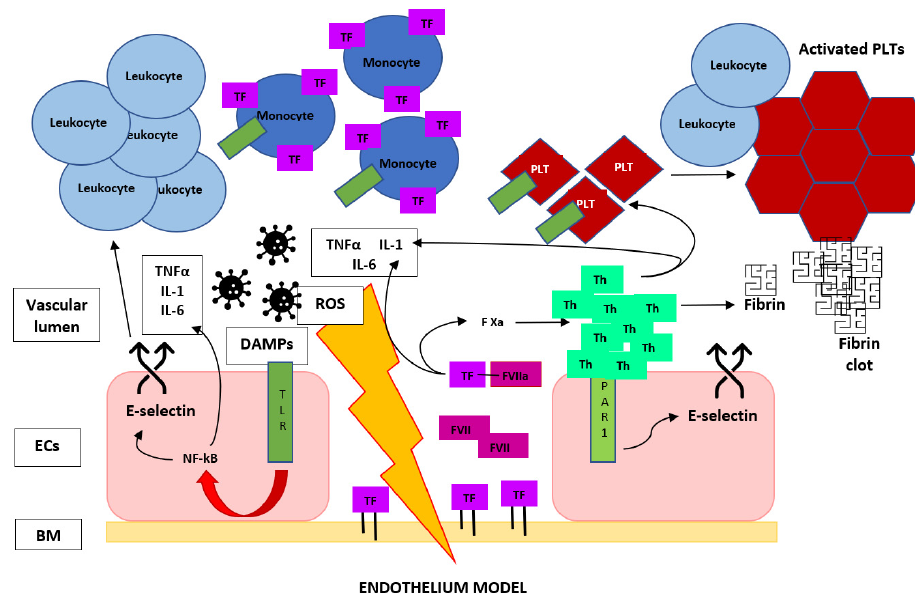
Figure 3. Brief graphic description of the escalating circle of events that start from vascular wall damage and lead to the crosstalk between the coagulation cascade and immune system in a potent positive feedback loop toward venous thrombus formation during sepsis, more underlying the essential role of TF and thrombin in DVT. TF, tissue factor; F VII(a), (activated) factor VII; F Xa, activated factor X; Th, thrombin; PLT, platelet; PAR-1, protease-activated receptor 1; TLR, Toll-like receptor; DAMPs, damage-associated molecular patterns; ROS, reactive oxygen species; ECs, endothelial cells and BM, basal membrane.